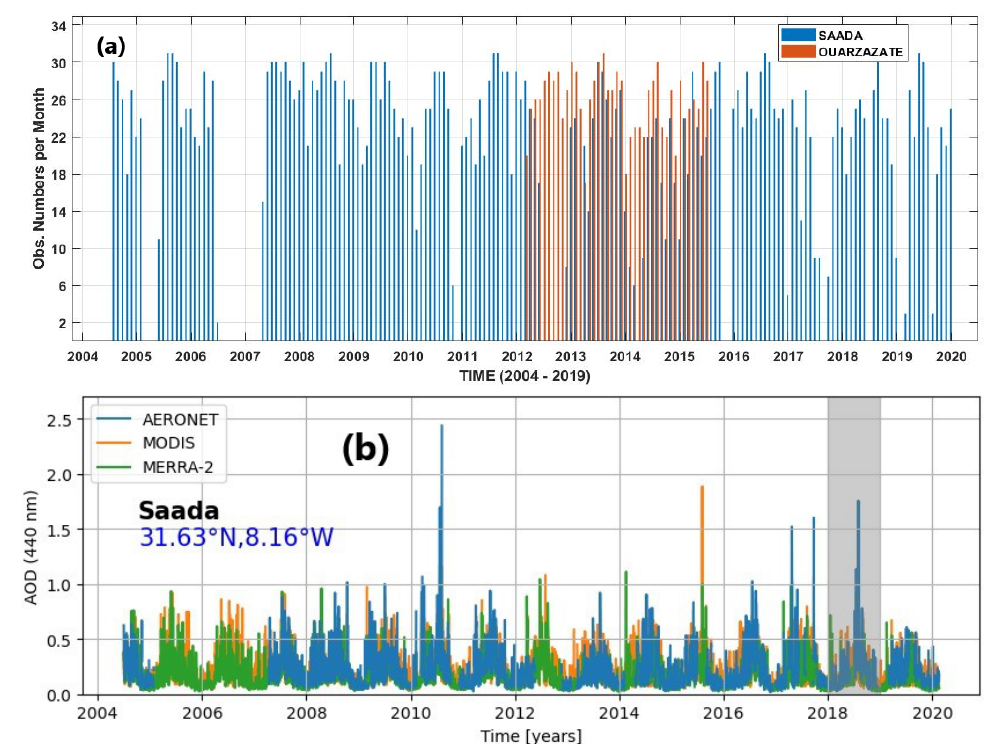
Figure 2. ( a ) Number density of aerosol measurements by AERONET sun-photometers at Saada (blue bars) and Ouarzazate (orange bars), from 2004 to 2019. ( b ) Daily AOD 440 time-series as recorded at Saada from sun-photometer (AERONET level 2.0 data) (red line), from MODIS observations (blue line) and from MERRA-2 assimilations (dashed green line). The grey area frames the year of the study event